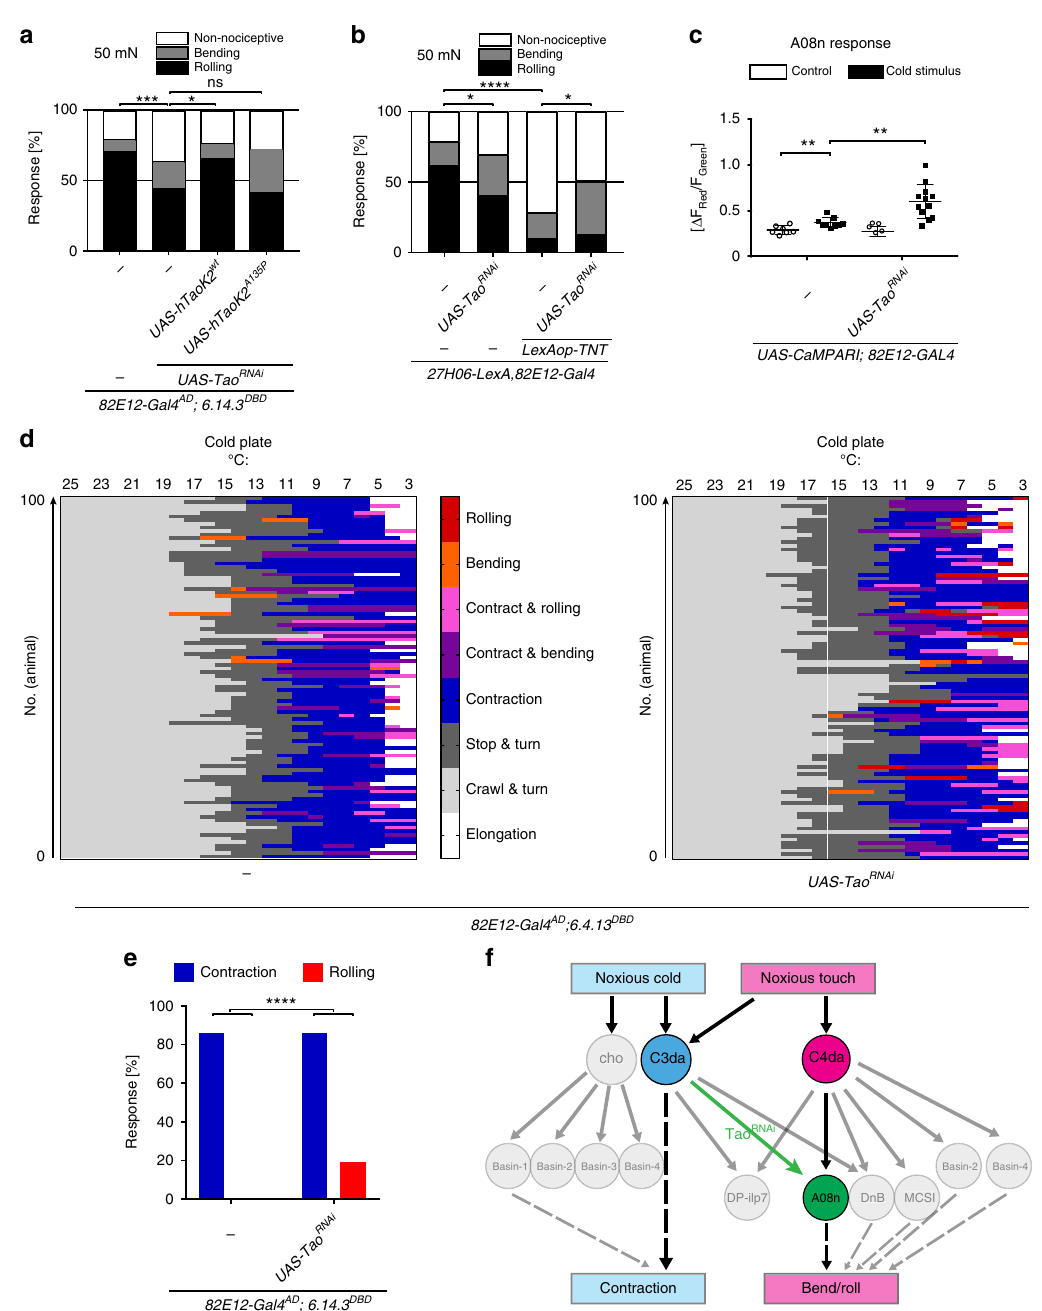
Fig. 7 Loss of Tao in A08n alters behavioral action selection. a Mechanonociceptive behavioral response of third instar larvae (96 h AEL) in control or with Tao RNAi without or with co-expression of hTaoK2 wt or hTaoK2 A135P in A08n neurons. Responses to the second mechanical stimulation with a 50 mN von Frey fi lament are shown (Nociceptive rolling and bending or non-nociceptive responses). * P < 0.05, *** P < 0.001. Control : n = 98, UAS-Tao RNAi n = 99, UAS- Tao RNAi + hTaoK2 wt : n = 99, UAS-Tao RNAi + hTaoK2 A135P : n = 98. Control vs. UAS-Tao RNAi : P = 0.0006, UAS-Tao RNAi vs. UAS-Tao RNAi + hTaok2 wt : P = 0.0109, UAS-Tao RNAi vs. UAS-Tao RNAi + hTaok2 A135P : P = 0.1006, Χ 2 -test. b Mechanonociceptive behavioral response of third instar larvae (96 h AEL) in control or Tao RNAi , Tetanus toxin light chain (TNT), or Tao RNAi with TNTe expression in A08n neurons. Responses to the second mechanical stimulation with a 50 mN von Frey fi lament are shown. * P < 0.05, **** P < 0.00005. Control n = 100, UAS-Tao RNAi : n = 100, LexAop-TNTe : n = 100, UAS-Tao RNAi + LexAop-TNTe : n = 100. Control vs. UAS-Tao RNAi : P = 0.0249, Control vs. LexAop-TNT : P > 0.0001, LexAop-TNT vs. UAS-Tao RNAi + LexAop-TNT : P = 0.0201, Χ 2 -test. c A08n calcium responses to a 4 °C cold stimulus based on CaMPARI photoconversion without or with Tao RNAi expression in A08n neurons. ** P < 0.005, control vs. control cold P = 0.0066, control cold vs. UAS-Tao RNAi cold P = 0.002. Unpaired two-tailed t -test. Control n = 7, Control cold: n = 9, UAS-Tao RNAi control n = 9, UAS-Tao RNAi cold: n = 12. d Cold plate assay ethogram showing individual larval behaviors during continuous temperature reduction (25 – 3 °C) without or with Tao RNAi in A08n neurons (stop & turn, contraction, contraction & bending, contraction & rolling, bending and rolling). Control n = 100. UAS-Tao RNAi n = 100. e Percentage of larvae shown in d displaying contraction and pure rolling behavior. **** P < 0.0001, Χ 2 -test. f Model of C4da and C3da/cho circuits and Tao-dependent network changes. Ectopic connectivity between C3da and A08n neurons after loss of Tao results in